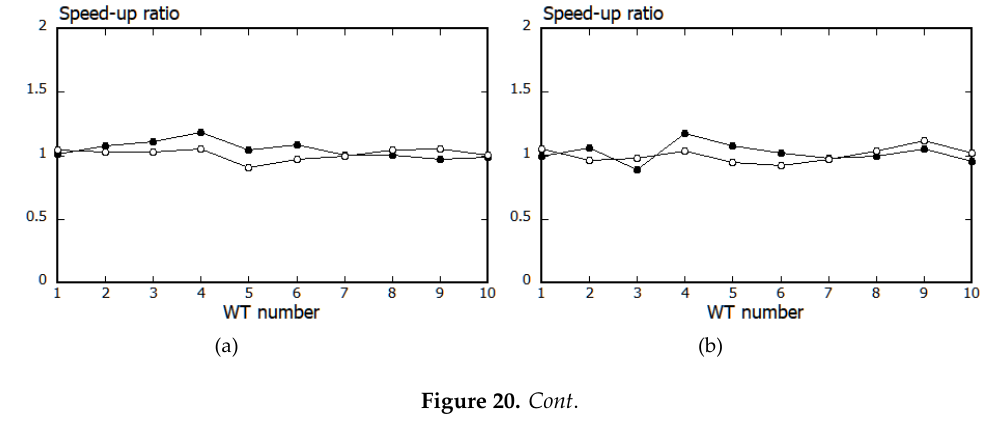
Figure 19. Sixteen wind sectors (each sector is 22.5 degrees).